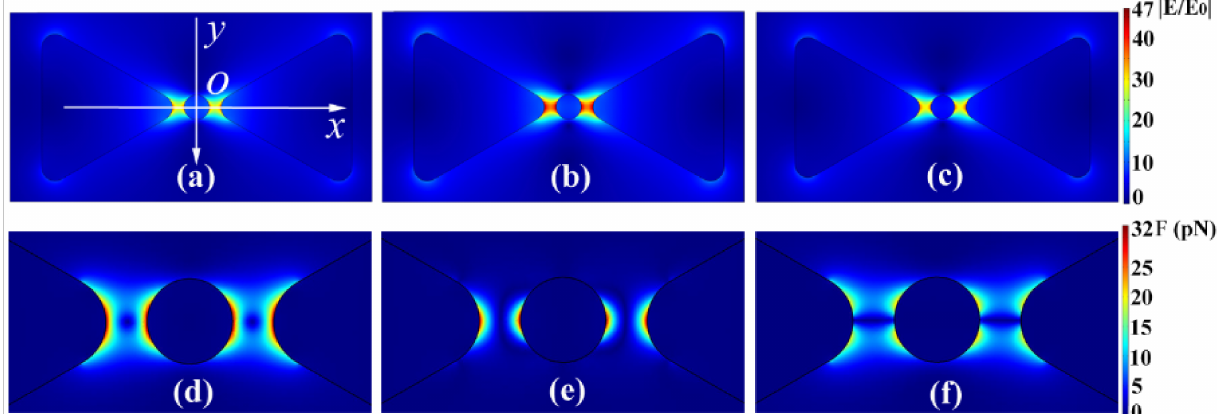
Figure 1. 2-D images of plasmonic electric-field enhancement localized within gap of a Au–Au bowtie dimer for the different wavelengths 545 nm ( a ), 560 nm ( b ), and 600 nm ( c ), and the corresponding plasmonic optical forces presented in normalized form in ( d ). x -direction component ( e ), y -direction component ( f ). The scale bar for optical force in ( d – f ) is in units of pN. The bowtie edge length is 20 nm, the bowtie dimer gap is 15 nm, and a trapped 5 nm Au sphere is considered here.